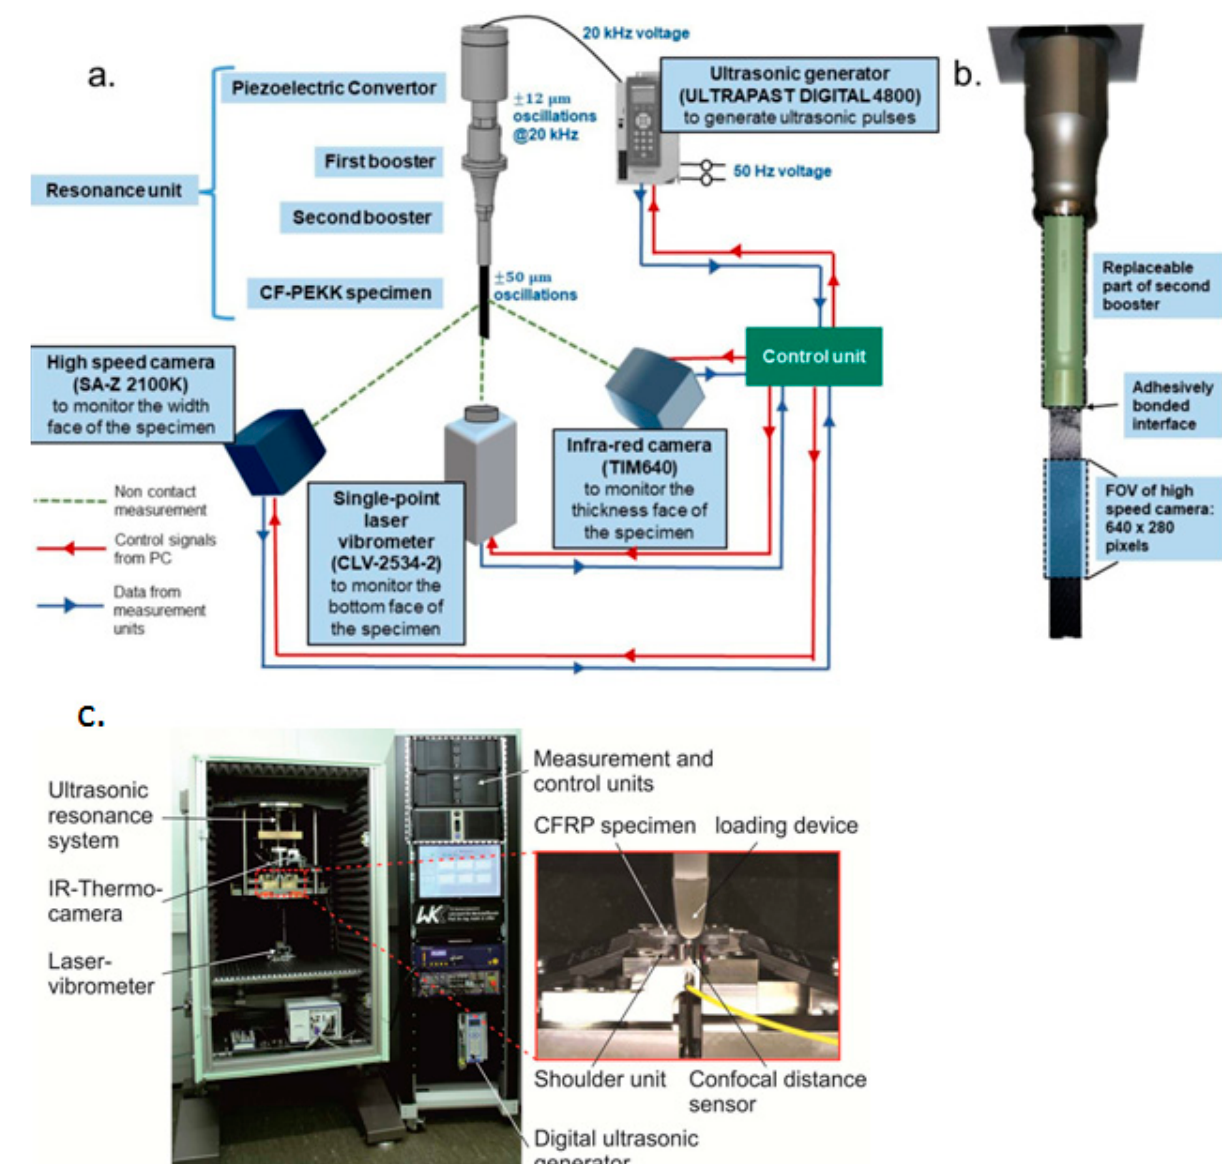
Figure 52. ( a ) Schematic experimental setup of the developed ultrasonic testing facility for axial cyclic loading of PMCs at a frequency of 20 kHz; ( b ) connecting the specimen to the system using the high-speed camera [29]; ( c ) ultrasonic testing setup for 3-point fatigue bending of CFRP (adapted with permission from Ref. [31]. Copyright © 2016 Elsevier Ltd.)